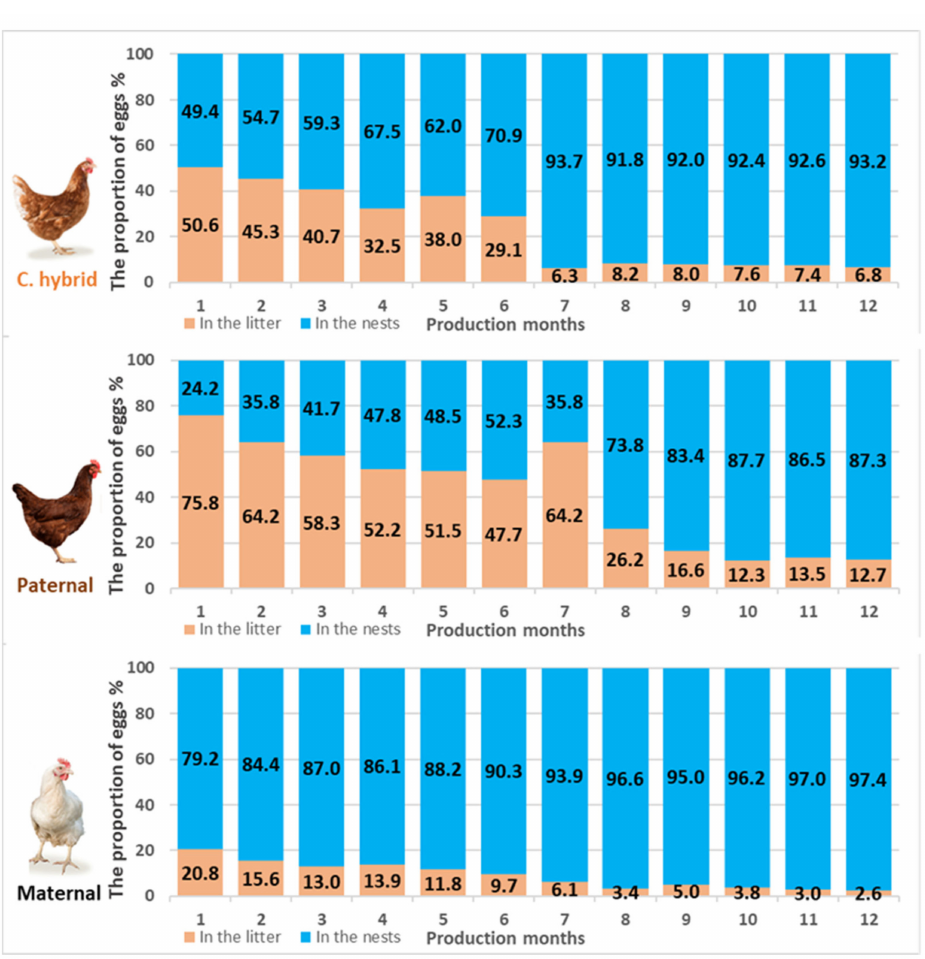
Figure 5. Changes in the proportion of eggs laid in the litter and in the nest during the 12 months of egg production in the case of the different